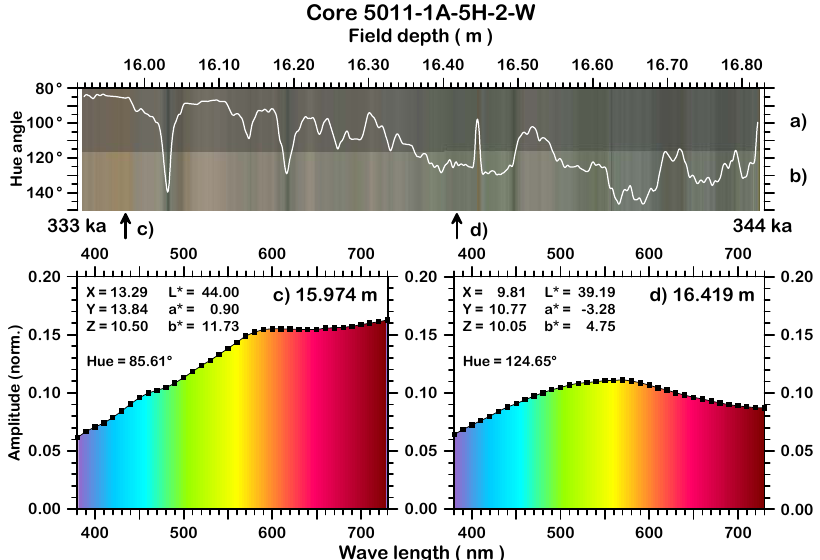
Fig. 3. Example for quantitative colour data acquisition from core 5011-1A-5H-W in field depth across Termination IV (time interval from 344 to 333ka): (a) original and (b) contrast-enhanced down-core variation of colours measured with a GretagMacbeth Spectrolino ™ spec- trophotometer, together with hue angle (white curve), (c) and (d) two individual spectra including tristimulus values ( X,Y,Z ), ( L ∗ ,a ∗ ,b ∗ ) values, hue angle (see Fig. 2), and logging depth. The positions of the two measuring points are marked by arrows below (b)